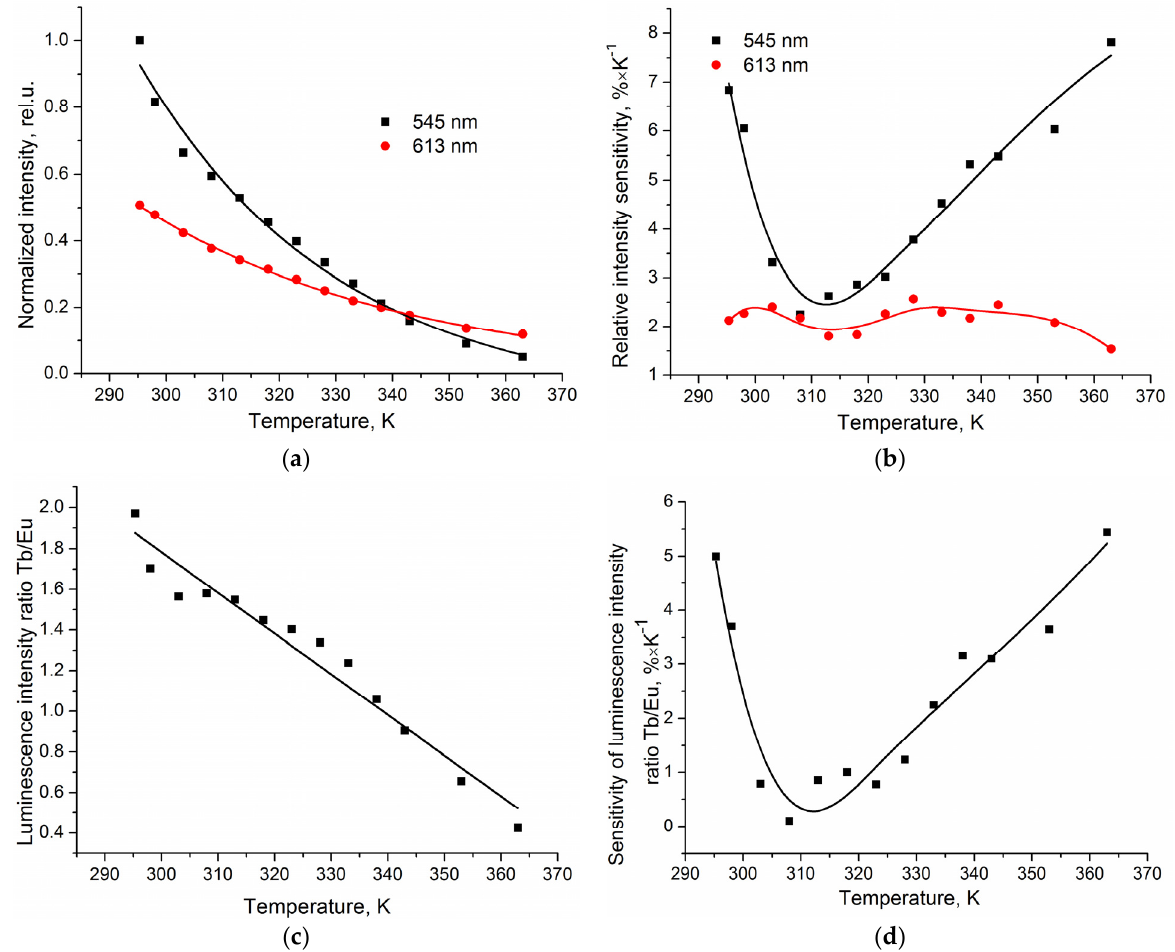
Figure 5. Temperature dependences of the normalized luminescence intensity ( a ), relative sensitivity of intensity ( b ), the ratio of luminescence intensities of the transitions 5 D 4 → 7 F 5 (Tb(III), 545 nm) and 5 D 0 → 7 F 2 (Eu(III), 613 nm) ( c ), and the sensitivity of the luminescence intensity ratio of the 3%Eu5%Tb composite film ( d ) at λ ex = 330 nm.